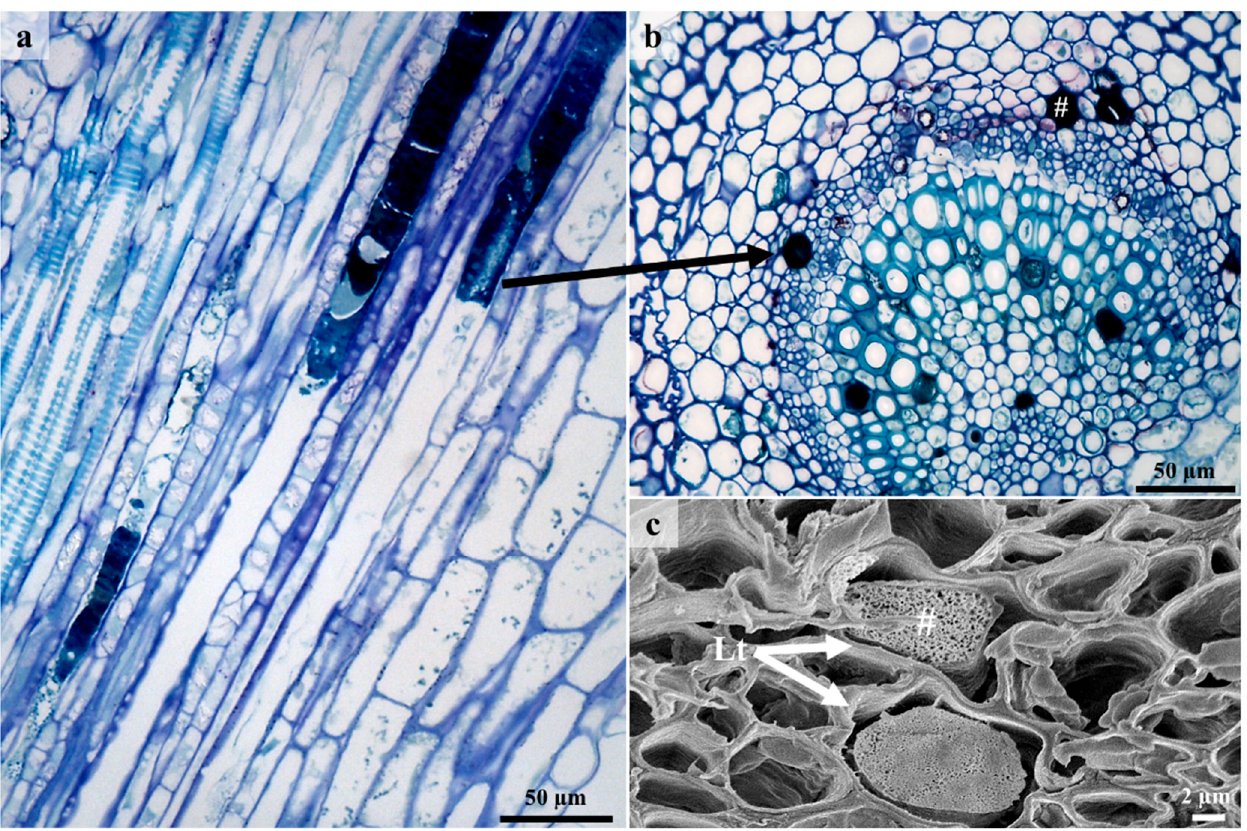
Figure 7. Laticifer cells showing secretory contents. ( a ) Longitudinal section of leaf showing latex within non-articulated laticifers. ( b ) Light micrograph of transverse section showing laticifer cells with latex contents. ( c ) Freeze—fracture through laticifer cells containing coagulated latex. Arrow – laticiferous cells containing latex, Lt—Laticifer, #—Latex.